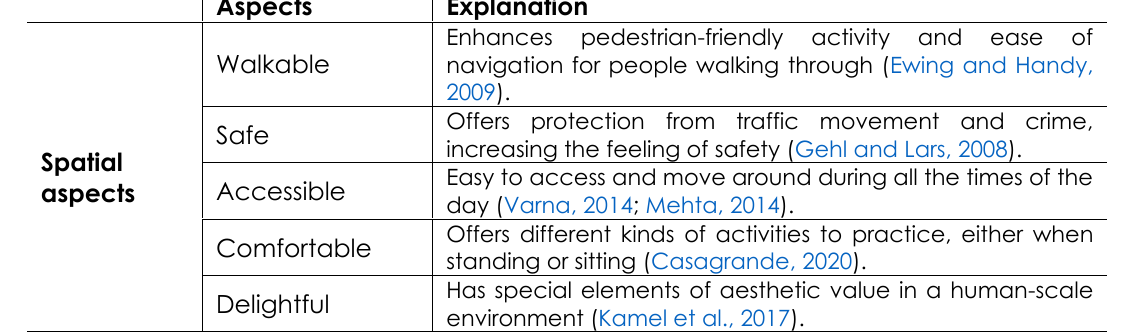
Table 2. Different aspects of human-centred public open